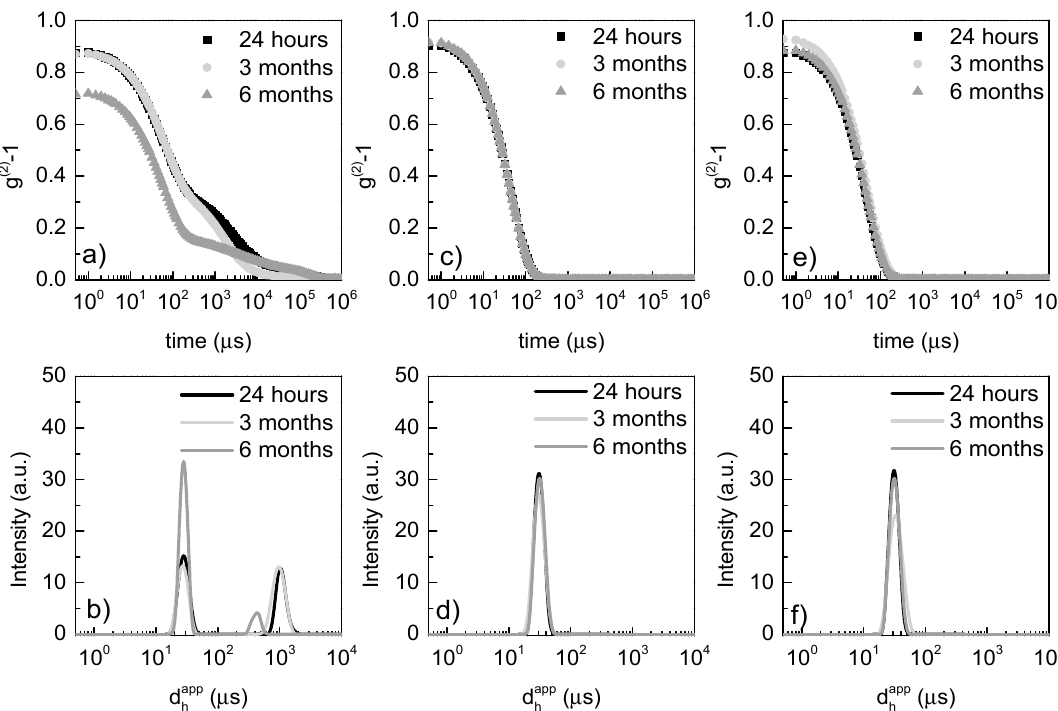
Figure 3. ( a ) Intensity auto-correlation functions for eugenol in water nanoemulsions loaded with tebuconazole (stock dispersion) after different times of storage at 25 °C. ( b ) Intensity-apparent hydrodynamic diameter distributions (obtained from the analysis of intensity auto-correlation functions in panel ( a )) for eugenol in water nanoemulsions loaded with tebuconazole (stock dispersion) after different times of storage at 25 °C. ( c ) Intensity auto-correlation functions for impregnation mixtures with tebuconazole concentration of 0.375 mg/mL obtained upon dilution a stock dispersion after different times of storage at 25 °C. ( d ) Intensity-apparent hydrodynamic diameter distributions (obtained from the analysis of intensity auto-correlation functions in panel ( c )) for impregnation mixtures with tebuconazole concentration of 0.375 mg/mL obtained upon dilution a stock dispersion after different times of storage at 25 °C. ( e ) Intensity auto-correlation functions for impregnation mixtures with tebuconazole concentration of 0.750 mg/mL obtained upon dilution of the stock dispersion after different times of storage at 25 °C. ( f ) Intensity-apparent hydrodynamic diameter distributions (obtained from the analysis of intensity auto-correlation functions in panel ( e )) for impregnation mixtures with tebuconazole concentration of 0.750 mg/mL obtained upon dilution of the stock dispersion after different times of storage at 25 °C.